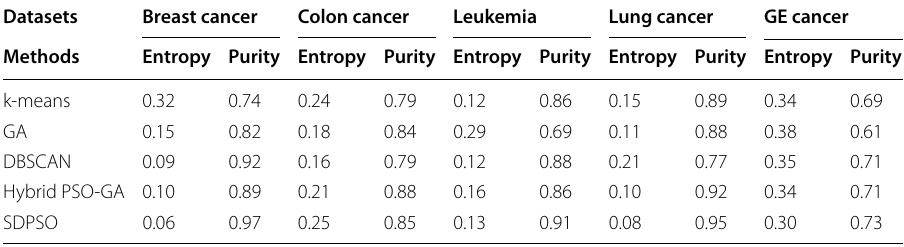
Table 8 Comparative results of SDPSO entropy and purity with k-means, GA, DBSCAN and hybrid PSO-GA for the five